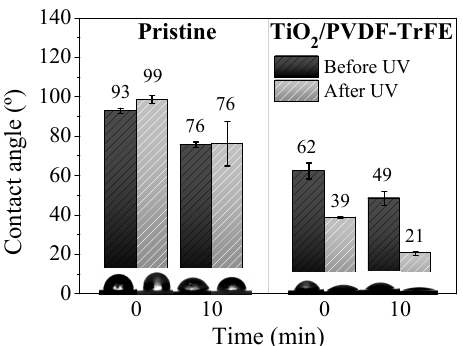
Figure 3. Average water contact angles of the pristine and TiO 2 /PVDF-TrFE membranes, before and after exposure to UV radiation for 30 min.